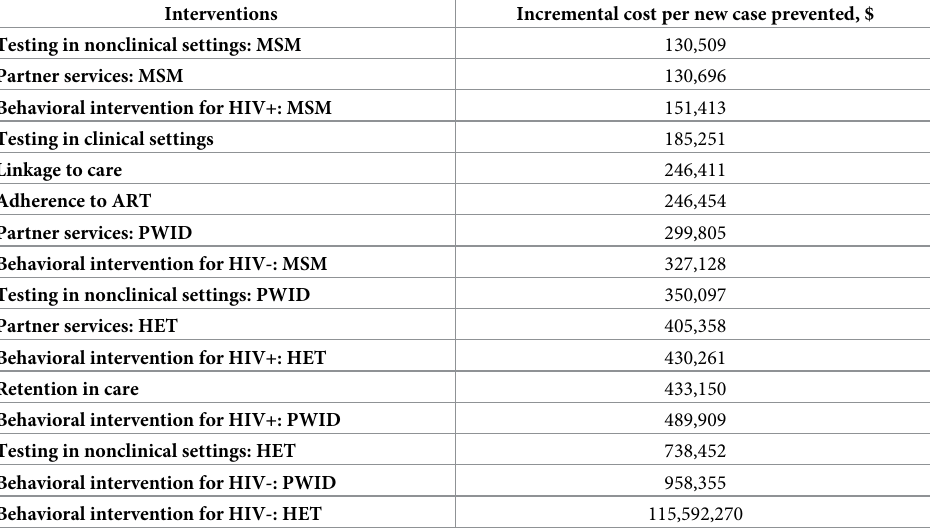
Table 3. Incremental cost per case of HIV prevented compared with the baseline/status quo by